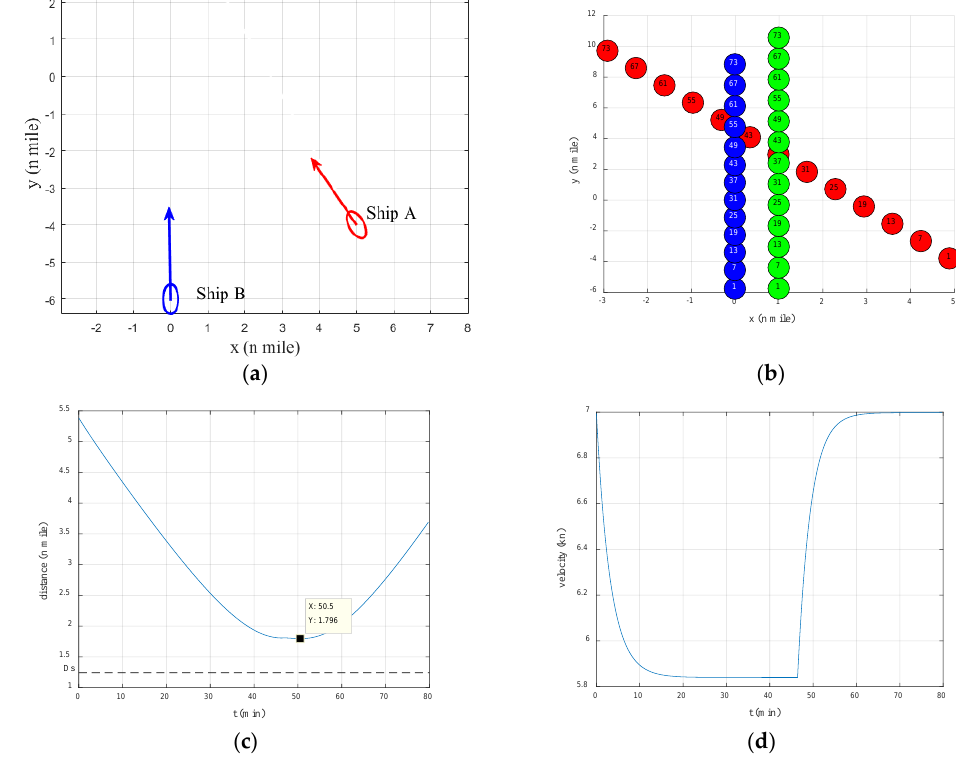
Figure 13. Simulation results for a large angle crossing situation. ( a ) Initial traffic configuration; ( b )